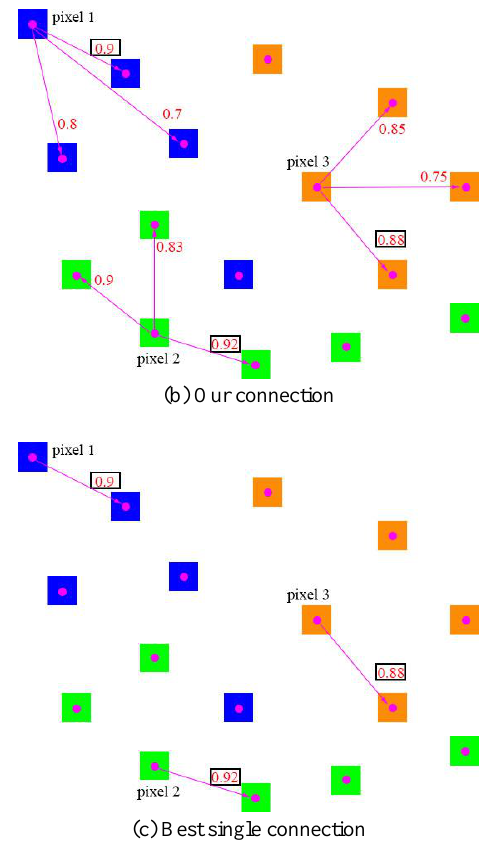
Fig.3 Majority voting strategy in source image